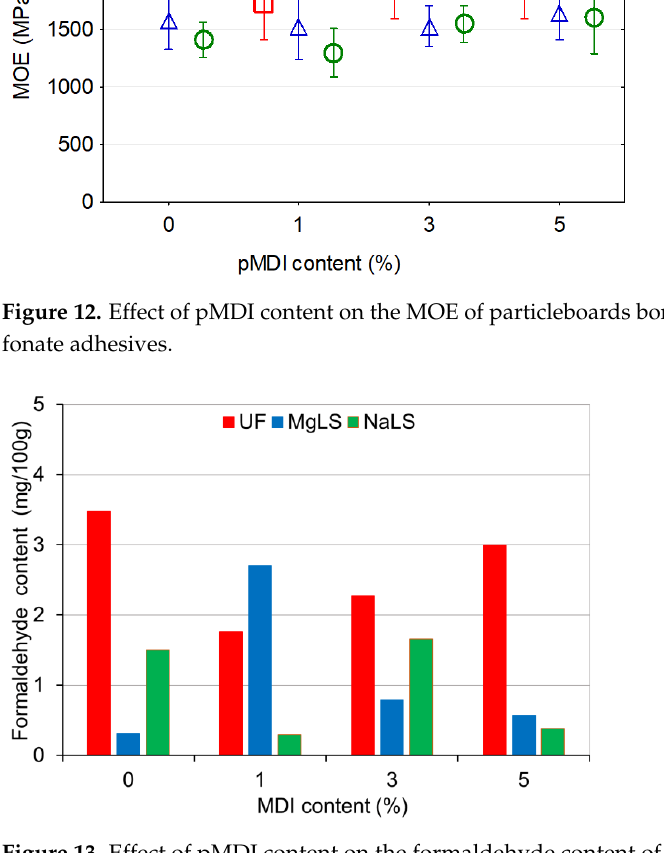
Figure 13. Effect of pMDI content on the formaldehyde content of boards made with pure UF and lignosulfonate adhesives.